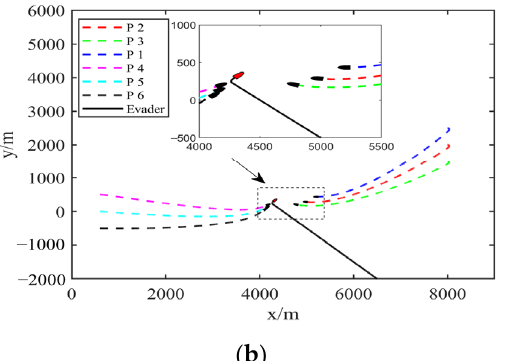
Table 1. General parameters of the USV model in simulations.